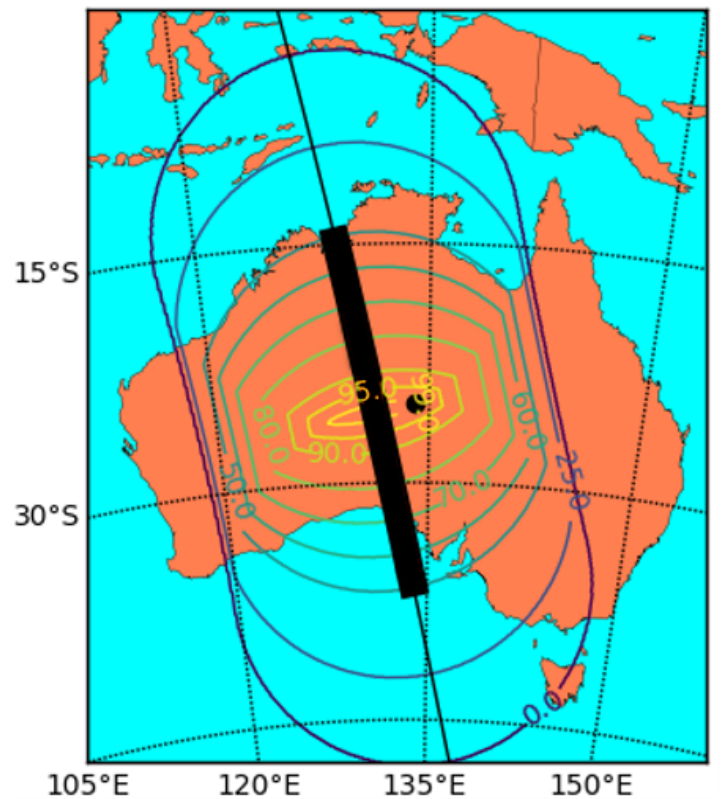
Figure 2. Contour plot showing the areas in which different fractions of the QKD transmission window are visible to the laser terminal. The black dot represents the QKD ground station, and the black bar represents the QKD transmission window.